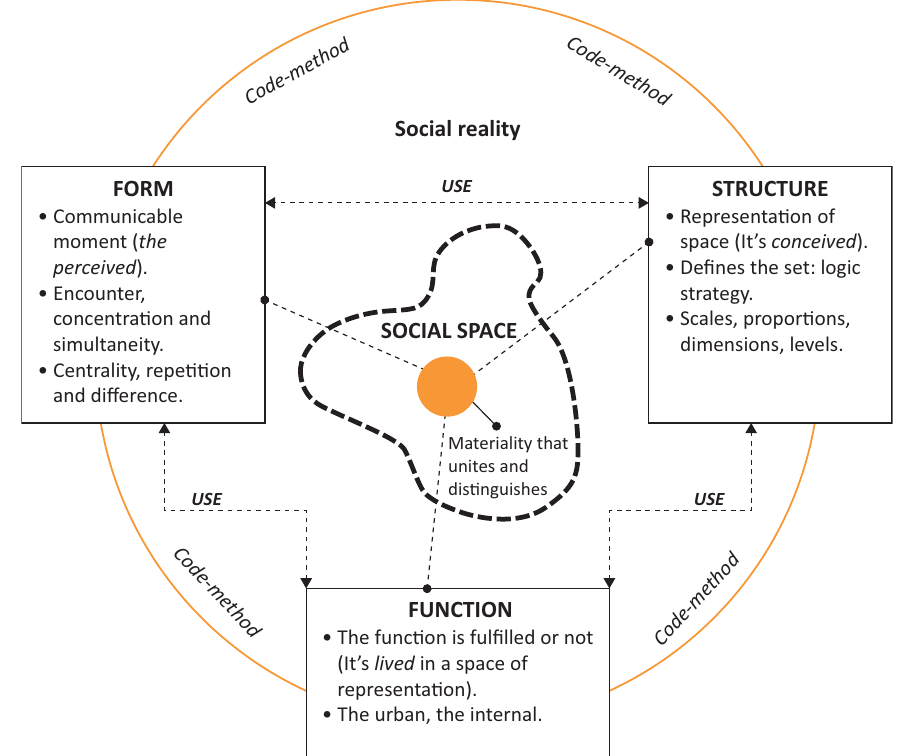
Figure 2. Diagram of the Lefebvrian methodological-theoretical analysis of social space as a social reality. Source: Jiménez Pacheco (2017b).